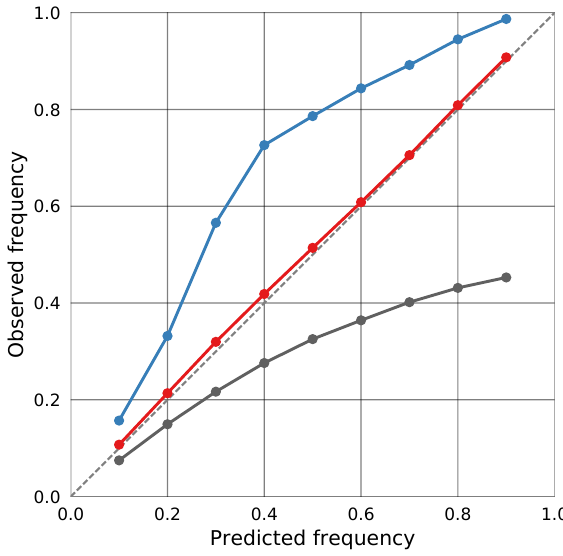
Figure 1. Example of a calibration plot displaying calibration curves for overly confident predictions (dark gray), well-calibrated predictions (red) and overly cautious predictions